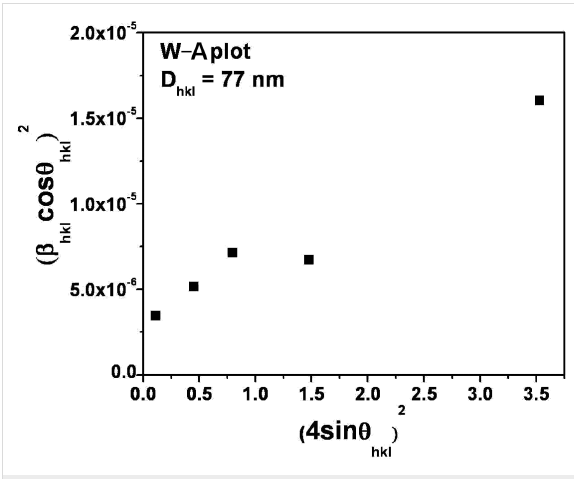
Figure 2: W–A plot of h-MoO 3 for crystallite size and microstrain esti- mation.